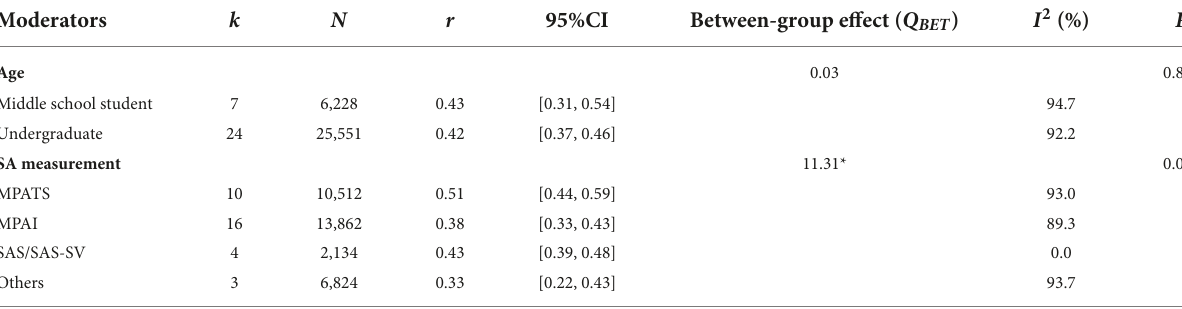
TABLE 3 Subgroup analyses of the summary correlation between SA and alexithymia.